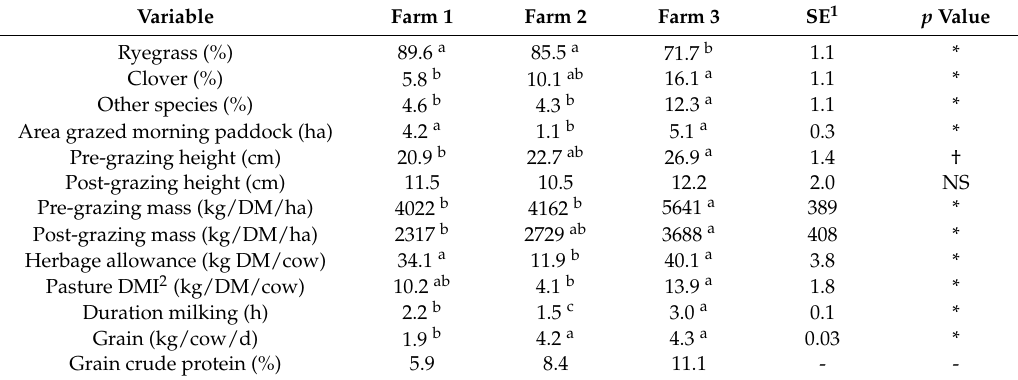
Table 5. Pasture botanical composition (%), herbage allowance, pasture intake, duration milking (h), grain-based concentrate allocated (kg/cow/d), and grain crude protein % for each farm. Variable